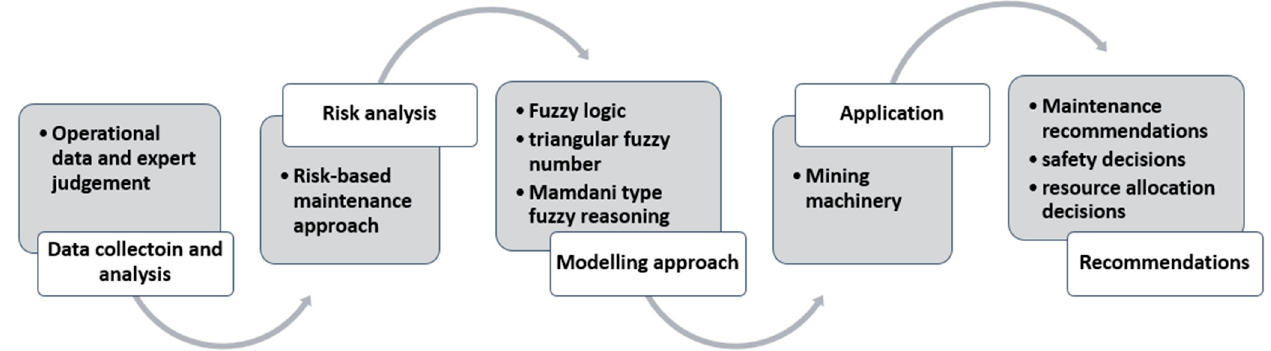
Figure 1. A framework of the developed decision-making solution.